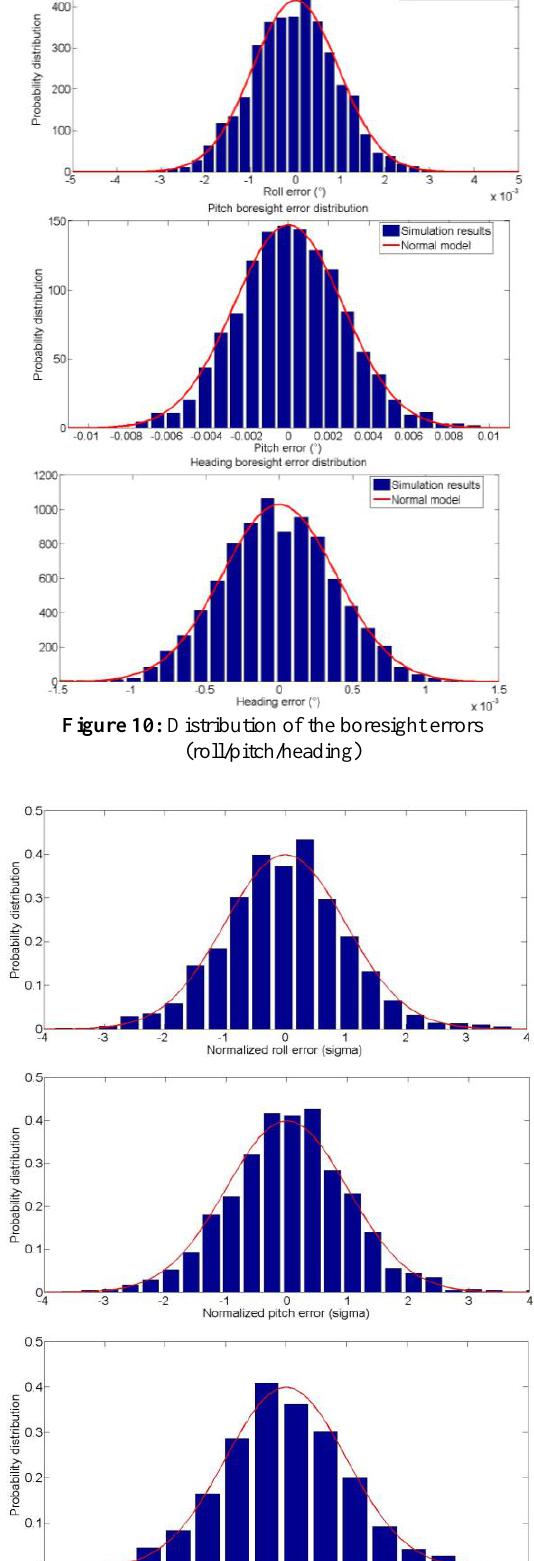
Figure 11: Roll/Pitch/Heading normalized